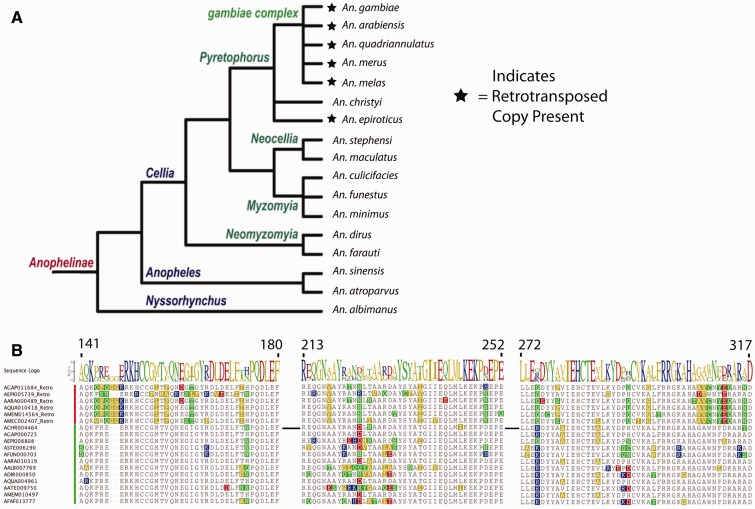
Retrotransposition of CC14 within the genus Anopheles. (A) Phylogenetic tree depicting retrotransposition event of CC14 in the Pyretophorus group. Species that possess the retrotransposed gene are annotated with a star and include A. gambiae, An. arabiensis, An. quadriannulatus, An. merus, An. melas, and A. epiroticus. We do not detect a retrotransposed copy of CC14 in A. christyi, but this may be due to a suboptimal genome assembly for this species (Neafsey et al. 2014). Dendogram is modified from Neafsey et al. (2013). (B) Regions of alignment of retrotransposed and original paralogous CC14 proteins across Anopheles. Retrotransposed genes include “_Retro” at the end of the gene identifier, with red highlight to the left of sequences. Spliced orthologs have a green highlight to left of sequences. Species are given the following identifiers: A. christyi (ACHR), A. gambiae (AGAP), An. epiroticus (AEPI), A. arabiensis (AARA), A. quadriannulatus (AQUA), A. merus (AMEM), A. stephensi (ASTE), A. funestus (AFUN), A. albimanus (ALBI), A. dirus (ADIR), A. atroparvus (AATE), A. farauti (AFAF), A. melas (AMEC). Amino acid alignments shown are representations of selected portions of the total open reading frame for each gene, due to the more extensive total lengths of the complete open reading frames. Segments of the open reading frames presented are aa141–180, aa213–252, and aa272–317 in A. gambiae.